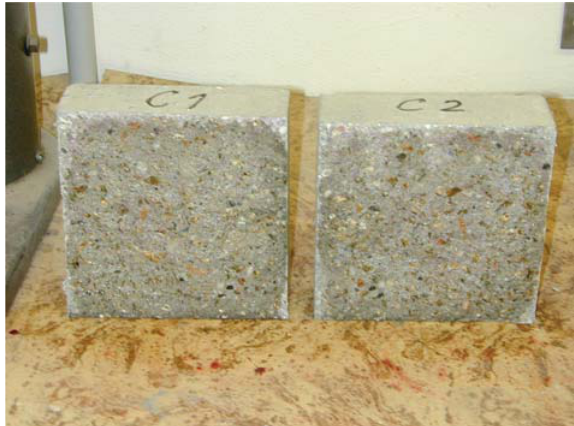
Fig. 1. Sample of formulation C placed in 98% CO days, carbonation depth 75 mm, real sectional dimensions of sample: 150×150 mm (Scale: 1:5)